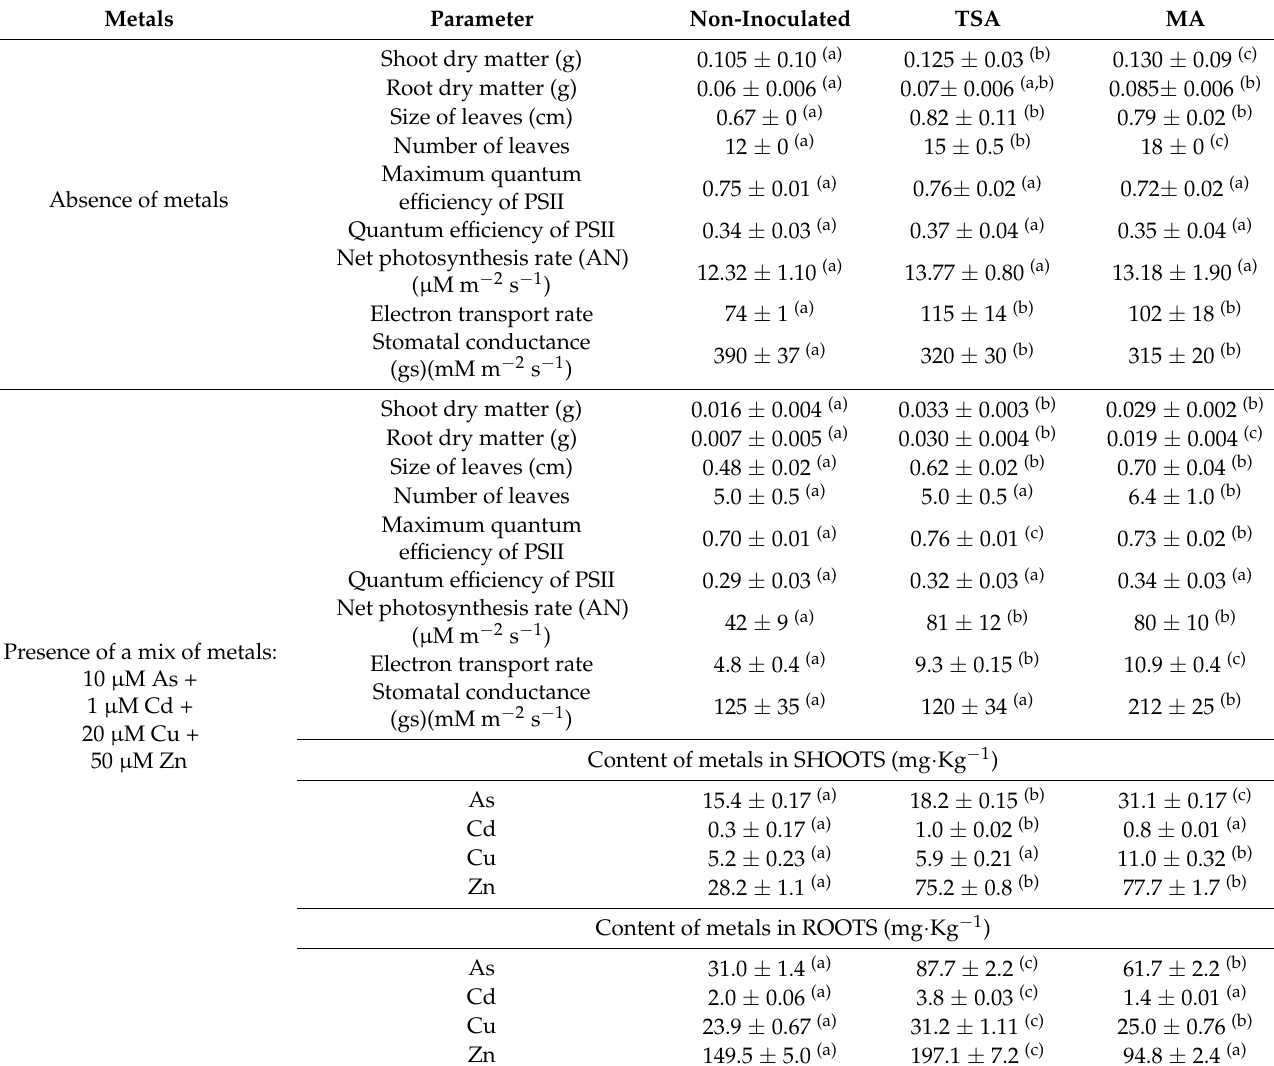
Table 6. Summary of results of inoculation of alfalfa ( Medicago sativa ) plants with consortiums TSA and MA in the absence and in the presence of metals/metalloids (10 µ M As + 1 µ M Cd + 20 µ M Cu + 50 µ M Zn). Effects on plant biometric parameters, physiological status of the plants and metal accumulation. Detailed information is provided in Supplementary Information File S1. Data are means ± standard deviations of three independent determinations and those significantly different from the non-inoculated control are indicated by different